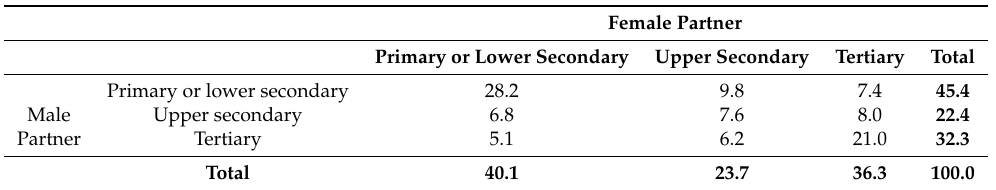
Table 2. Educational attainment and health status of individuals from co-residing couples aged 30–59. Spain 2012. Percentages.